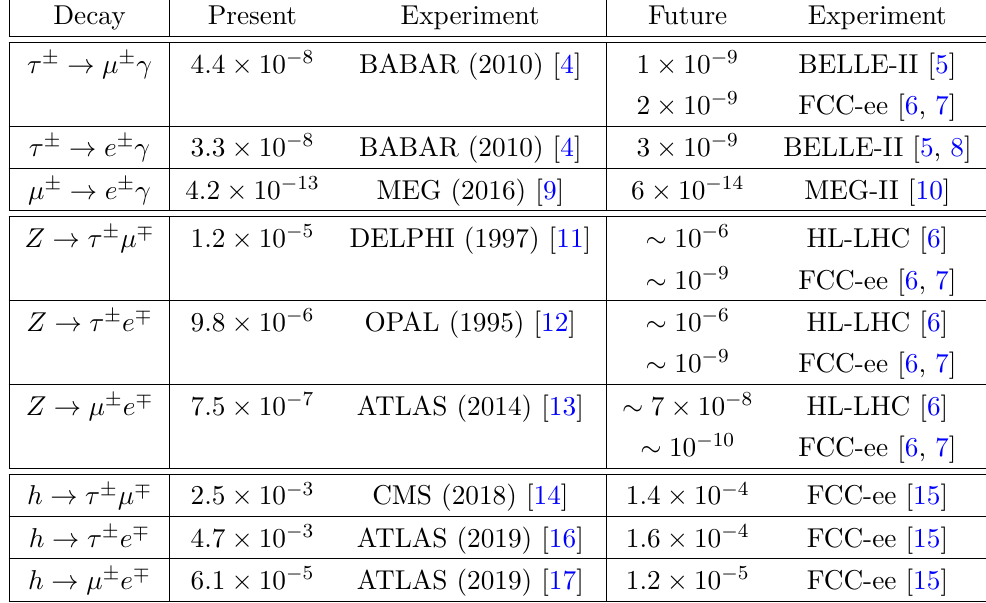
Table 1 . Present upper bounds and future sensitivities for the branching ratios of LFV decays.